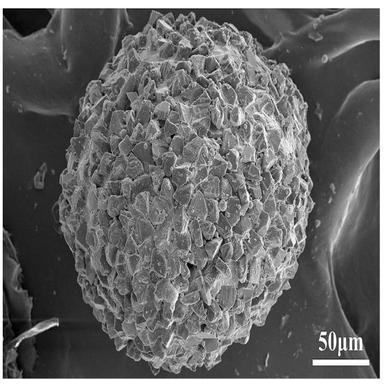
SEM image of cBN magnetic abrasive (flow rate 300 g/min) microscopic morphology after 80 min processing.